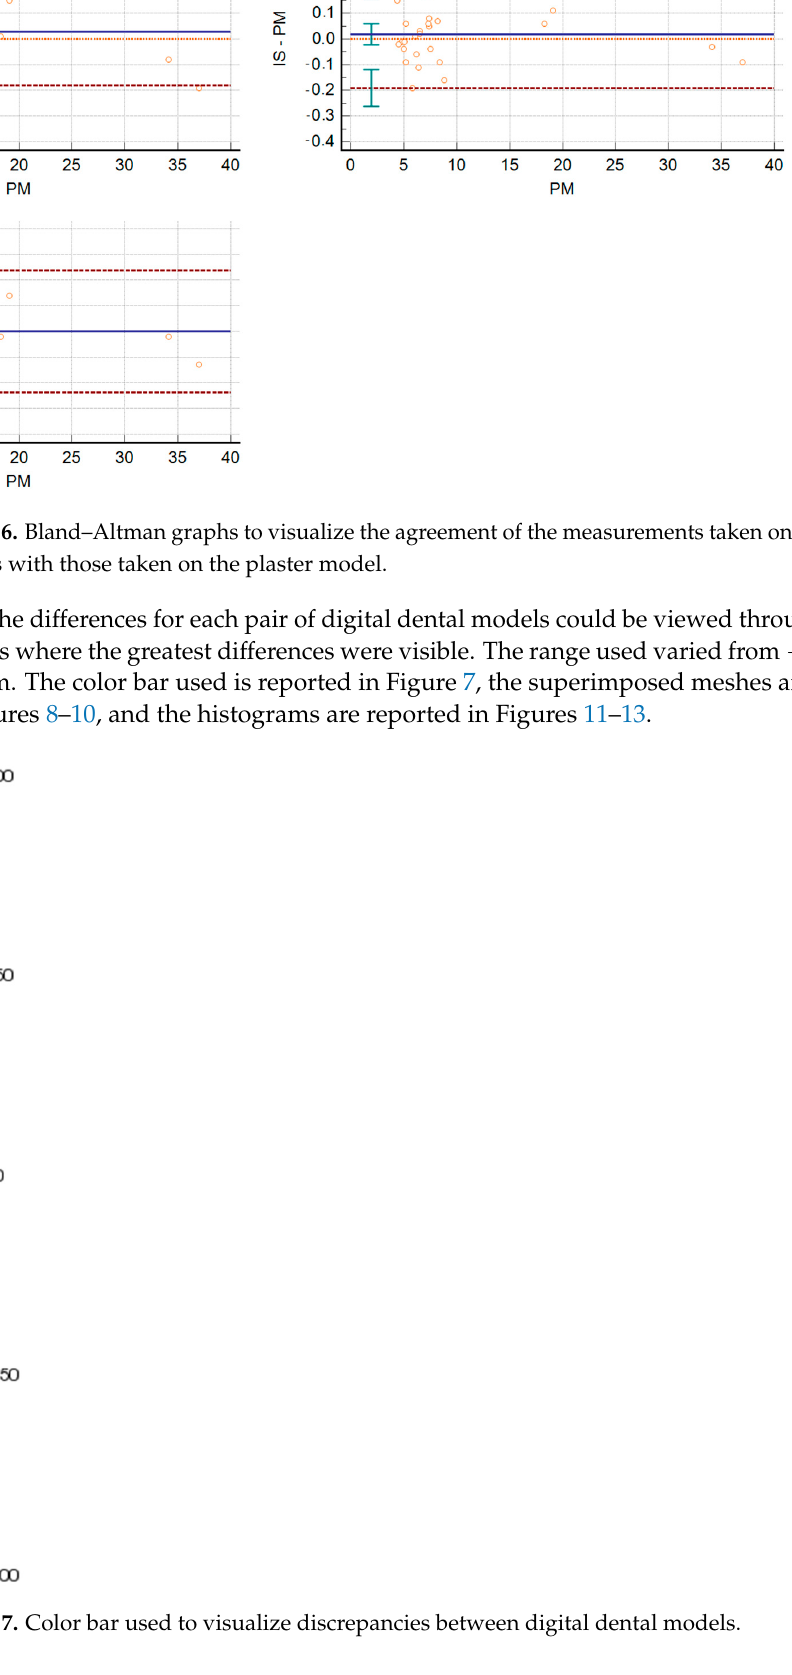
Figure 8. Superimposition between photogrammetry and dental extraoral laboratory scanner.